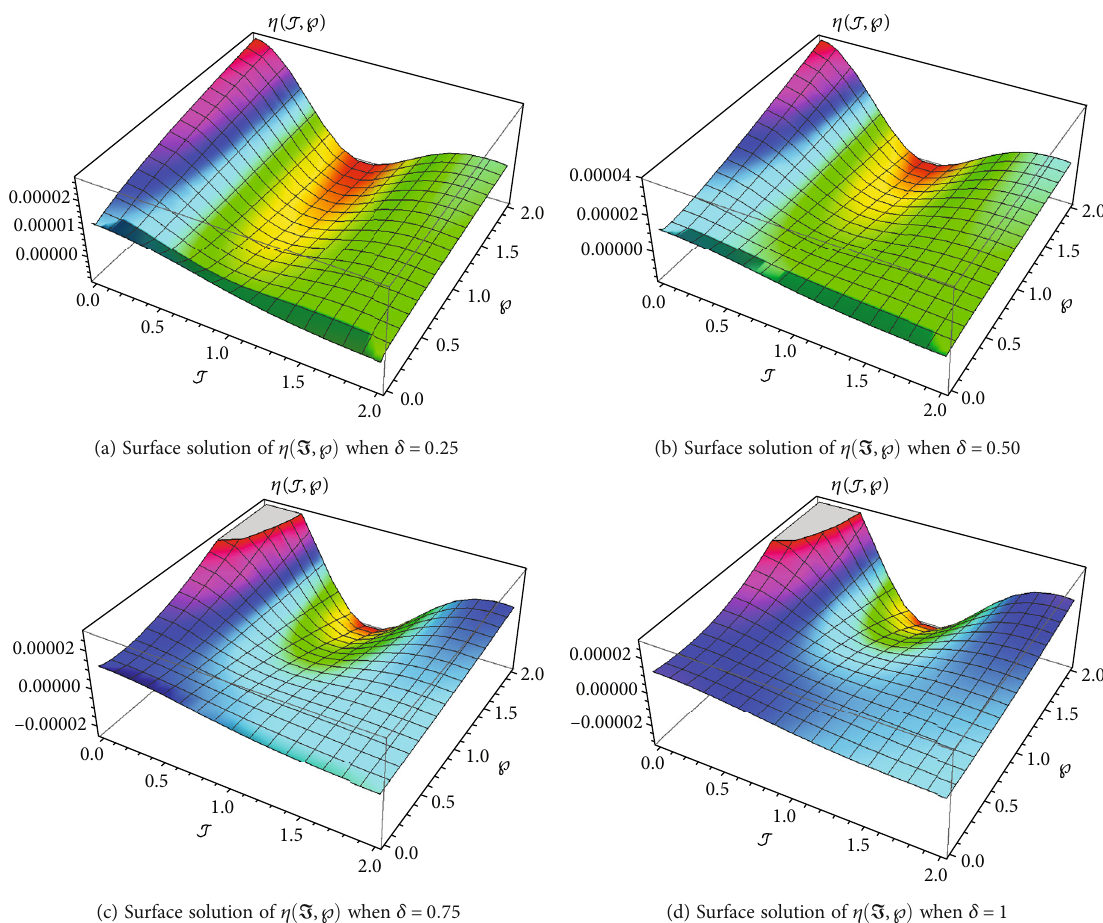
Figure 3: The surface solution of η ð I , ℘ Þ for distinct values of δ